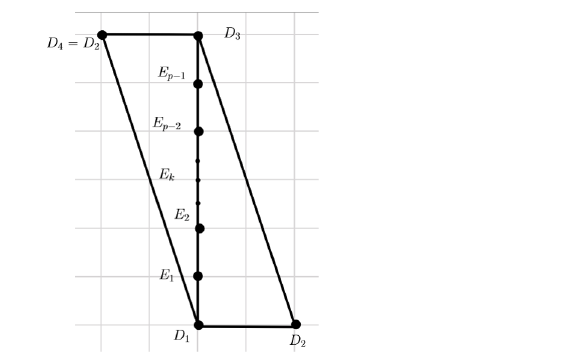
Figure 3. Diagram of the Z p -quotient of the conifold and its regular